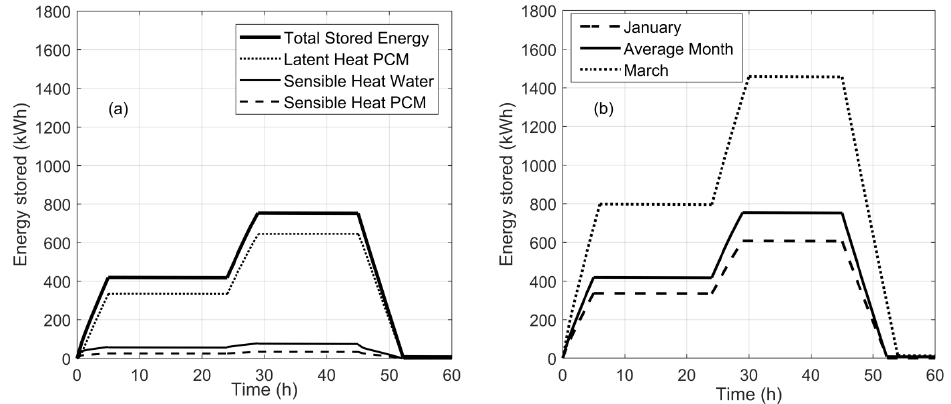
Figure 3. ( a ) Energy stored by phase change material (PCM) and water in the average winter month and ( b ) total energy stored for the three different cases.